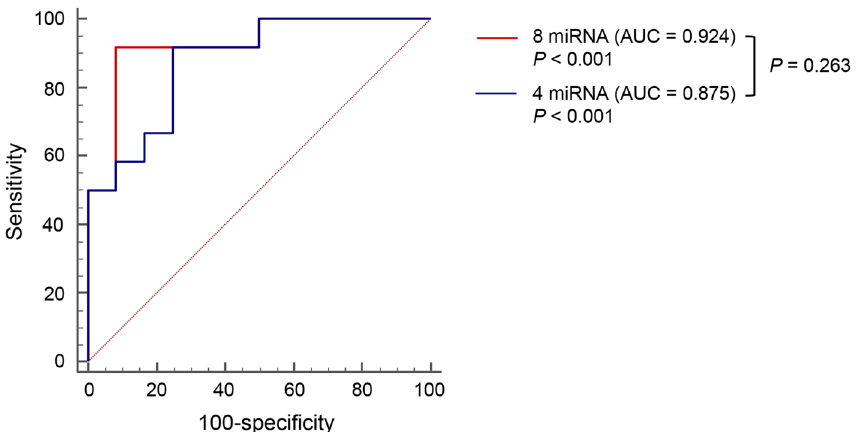
Figure 2. Diagnostic accuracy of miRNA combination. Receiver operating characteristic (ROC) curves for diagnostic accuracy for NASH using miRNA expression level from miRNA sequencing. The red line represents the ROC curve for a combination of eight miRNAs (miR-15b-3p, miR-21-5p, miR-29b-3p, miR-126-5p, miR- 151a-3p, miR-183-5p, miR-192-5p, and miR-4449). The blue line represents the ROC curve for the combination of four miRNAs (miR-21-5p, miR-151a-3p, miR-192-5p, and